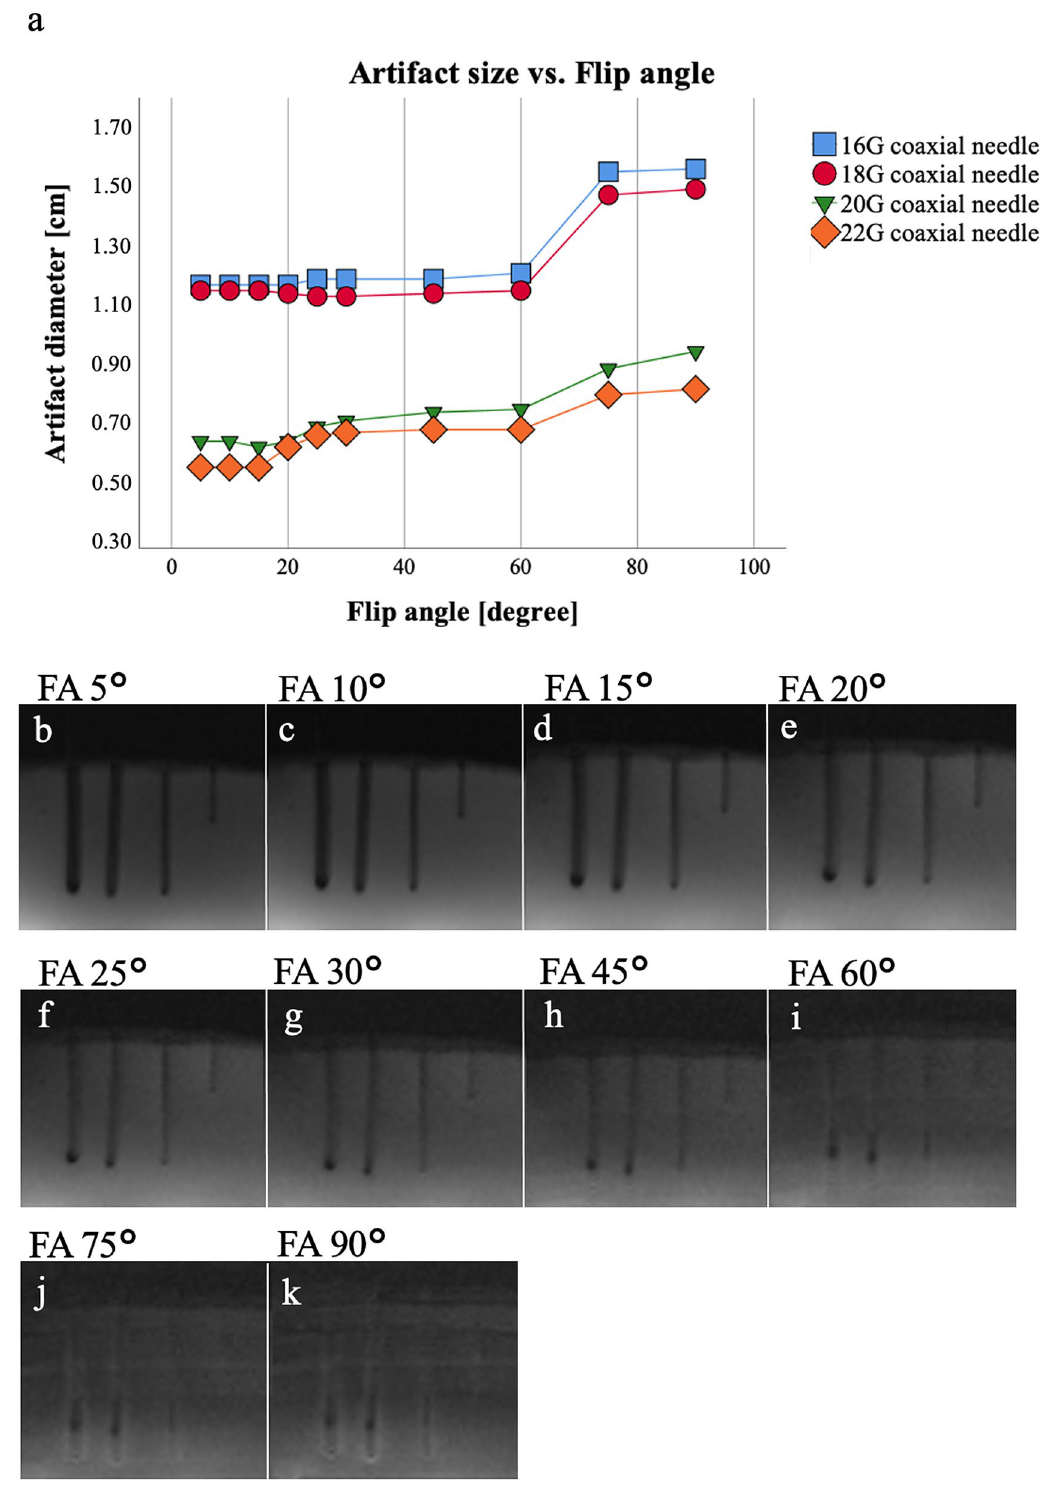
Figure 1. Scan series 1. Mean values (of both readers) of the measured artifact diameters ( a ) of the 16G, 18G, 20G, 22G needles with different FA of the T1-weighted GRE sequence. Note the positive correlation of artifact diameter and FA ( p ≤ 0.05) for 16G ( r = 0.859), 18G ( r = 0.816), 20G ( r = 0.965), and 22G ( r = 0.950) MR-compatible needles, in ( b – k ) the visual correlate is shown. Note the hyperintense rim around the central hypointense needle artifact occurring with FA > 45° representing as an alteration of the image contrast due to the needle. FA = flip angle, G =